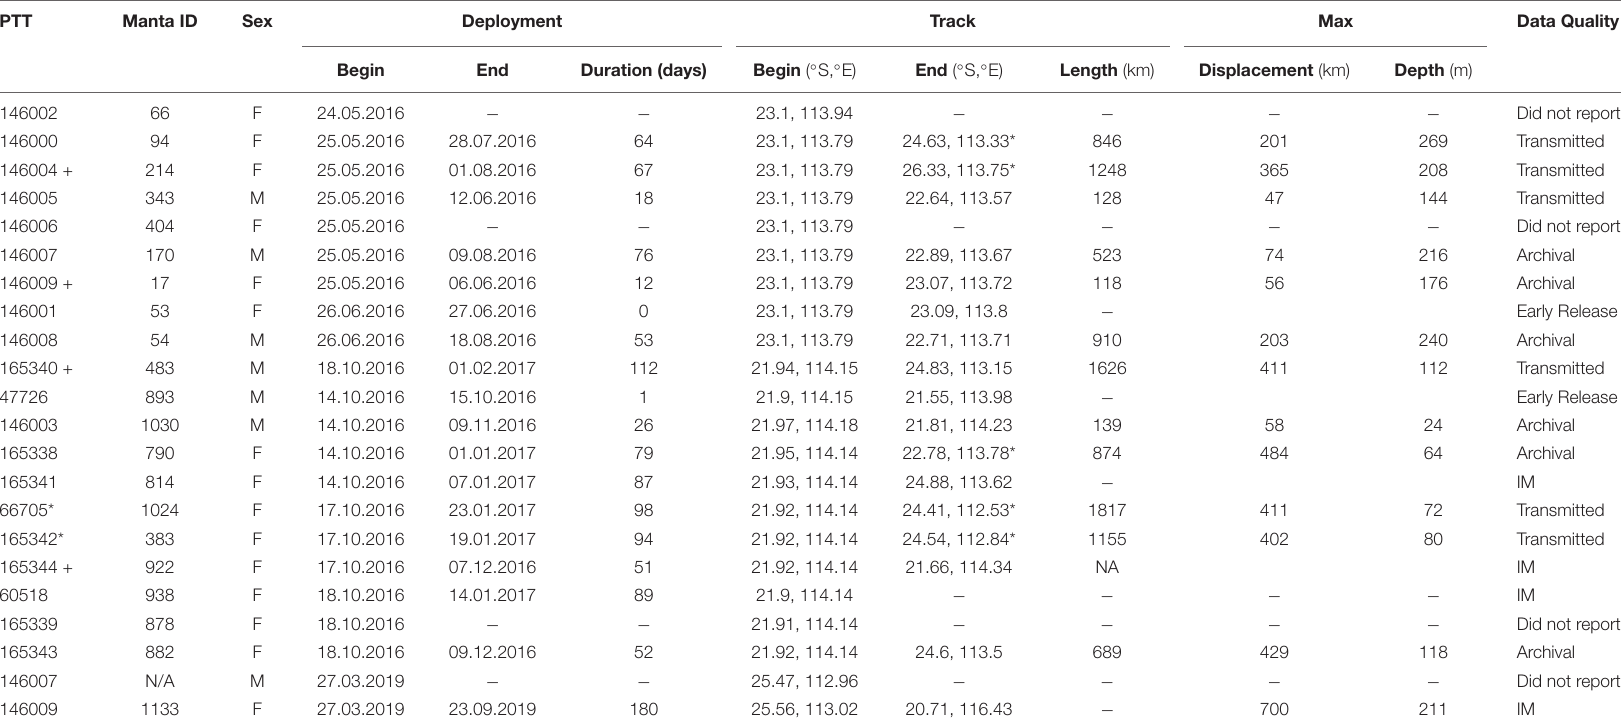
TABLE 1 | Metadata for 22 pop-up satellite archival tags deployed on M. alfredi in Western Australia between May 2016 and March 2019. PTT Manta ID Sex Deployment Track